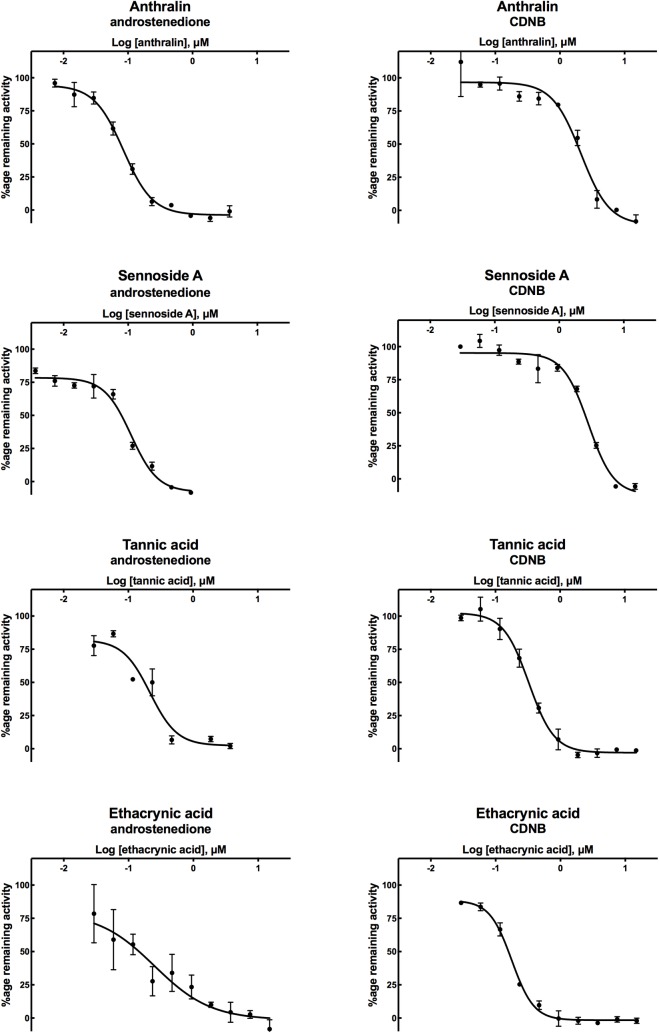
Dose-response curves of potent inhibitors of EcaGST A3-3 tested with the alternative substrates CDNB and Δ5-AD.Data points are means and standard deviations (SD) of triplicate measurements. The Hill coefficients represented by mean ± SD are for Δ5-AD inhibition: nanthralin = 1.9±0.19, nsennoside A = 2.1±0.29, ntannic acid = 2.1±0.63, nethacrynic acid = 1.0, and for CDNB inhibition: nanthralin = 2.0±0.43, nsennoside A = 2.2±0.41, ntannic acid = 2.2±0.23, nethacrynic acid = 2.5±0.21. The curve fitting for ethacrynic acid with androstenedione was not improved by using the Hill coefficient as a parameter and was therefore pre-set = 1.0 and presented no SD.